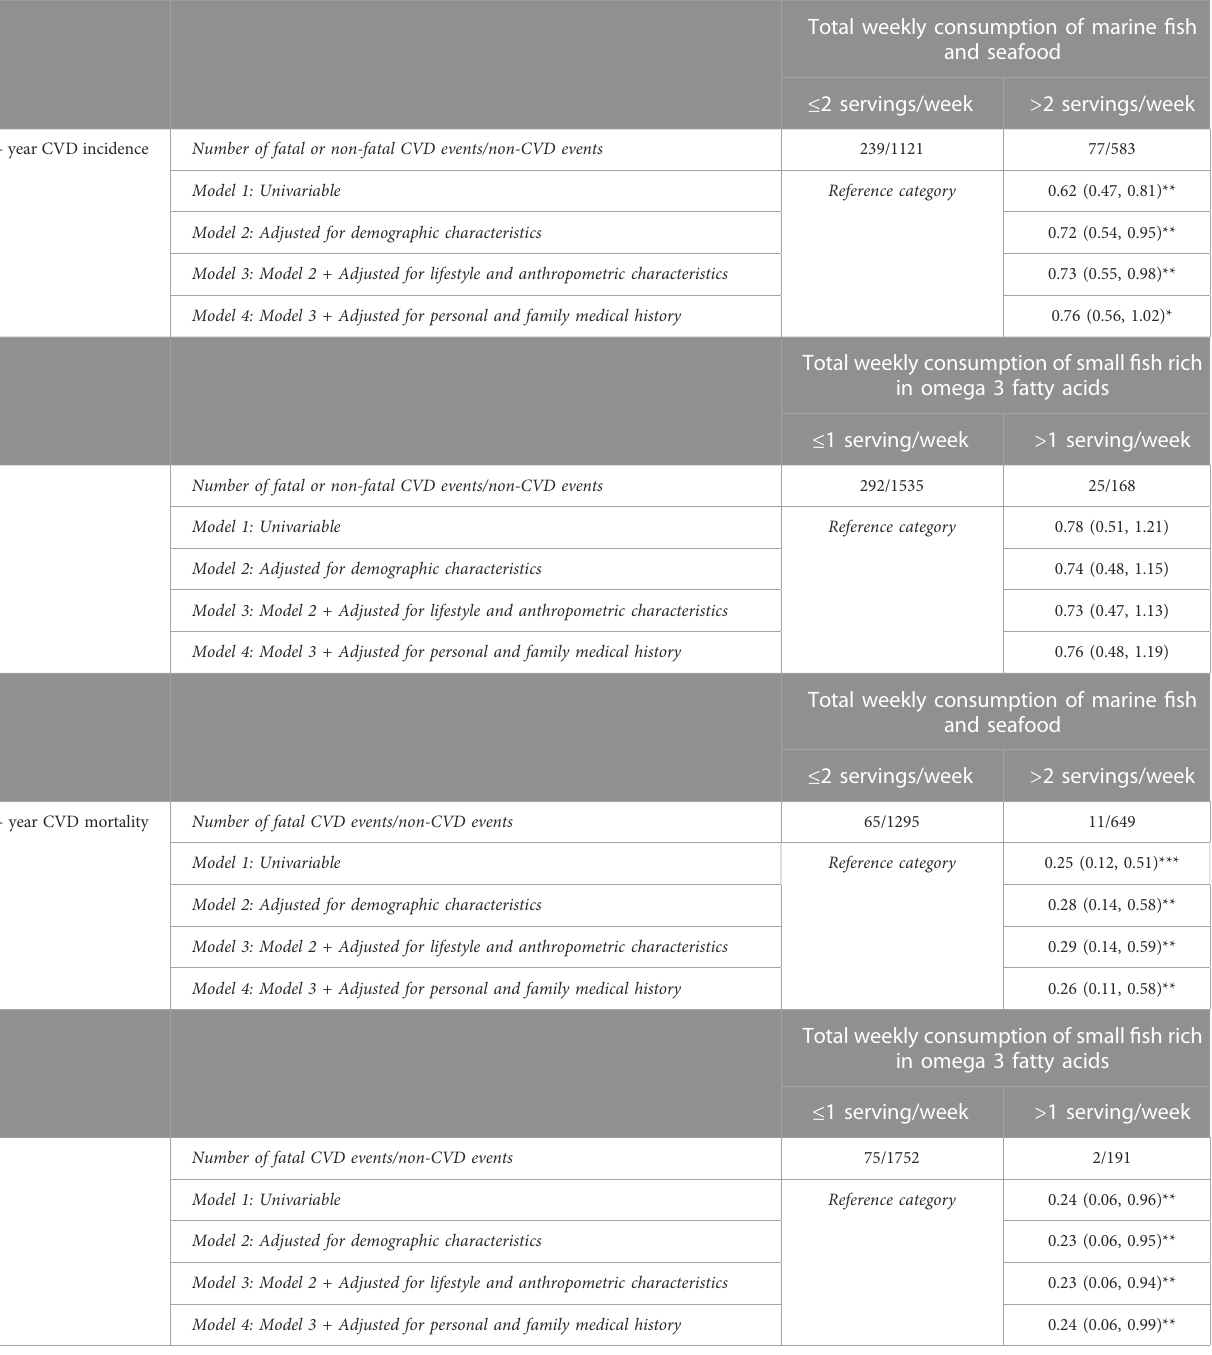
TABLE 2 Hazard Ratio (HR) and 95% Con fi dence Interval (95% CI) for fatal and/or non-fatal 10-year CVD events according to the weekly consumption of fi sh and seafood, as well as small fi sh rich in omega 3 fatty acids: The ATTICA Cohort Study,